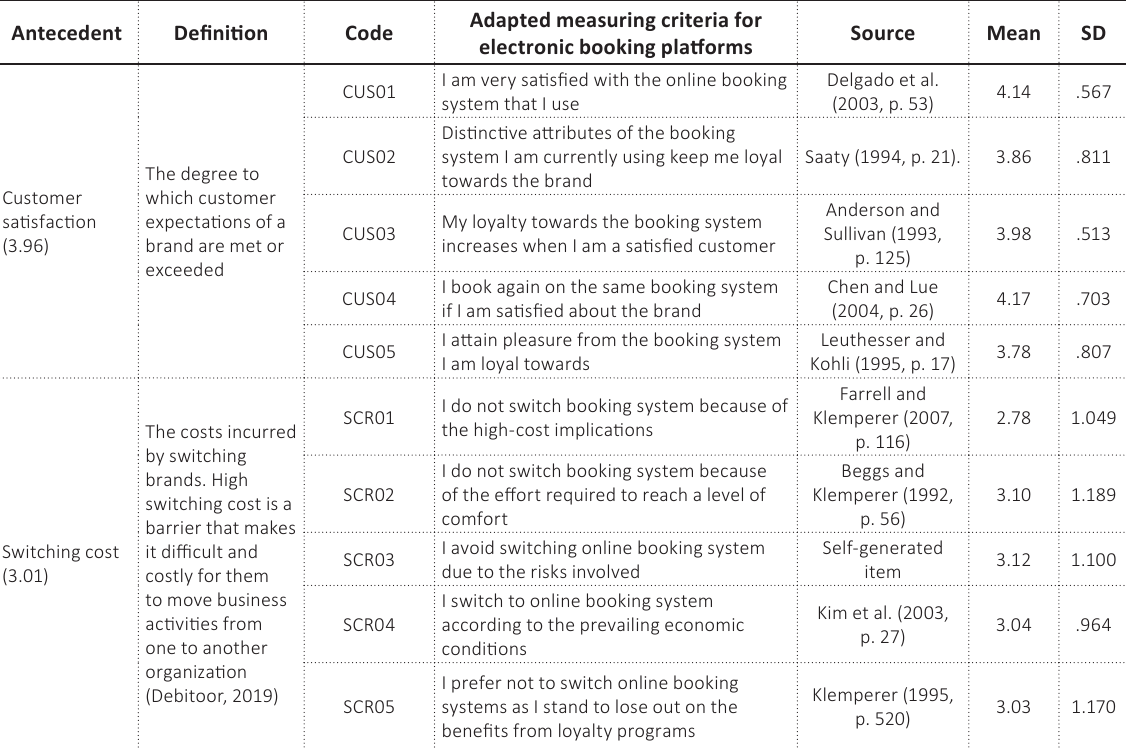
Table 1. Descriptive statistics and the origins of the questionnaire